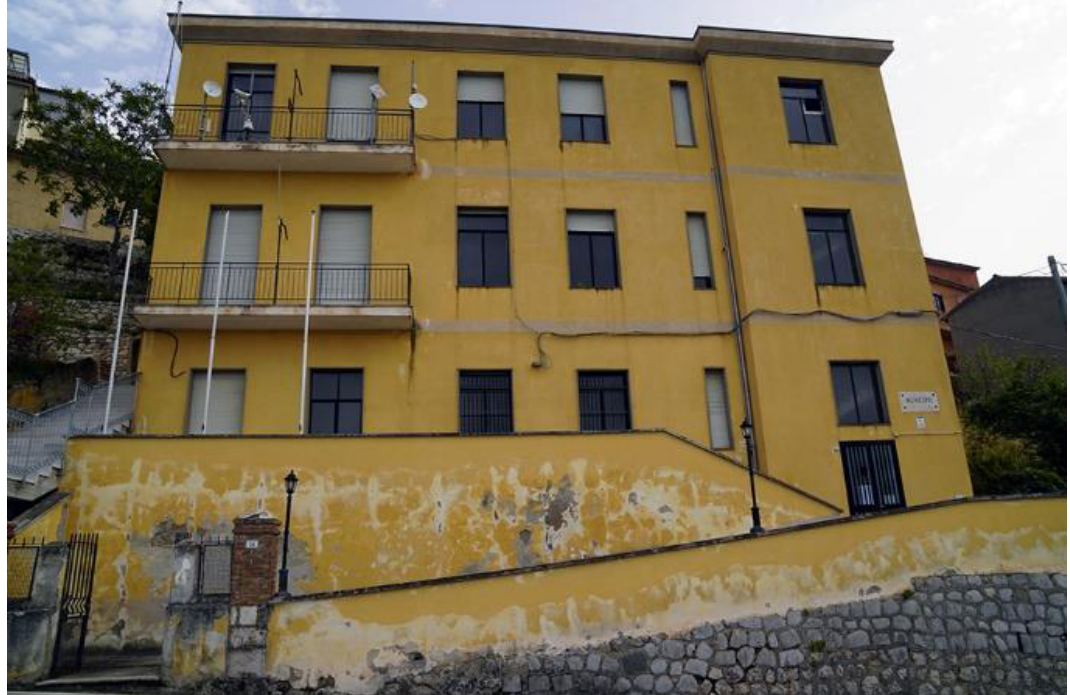
Figure 91. Salvitelle: the new Town Hall of the village (photos by [35,36]).